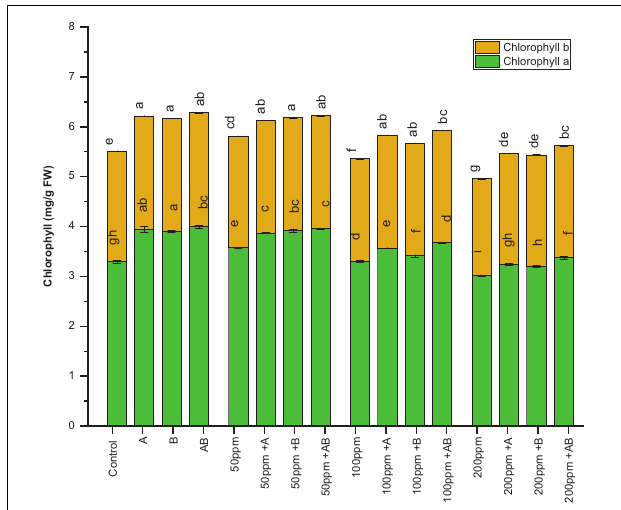
FIGURE 4 | Effect of heavy metal–resistant plant growth–promoting bacteria on chlorophyll a and chlorophyll b of wheat ( Triticum aestivum ) under control and heavy metal (Cd, Ni, Pb) stress conditions. Values are the mean of three replicates. Bars represent the standard error of means. Different letters above the bars indicate statistically significant difference between treatments at P ≤ 0.05. Details of treatments are the same as those in Figure 1 .